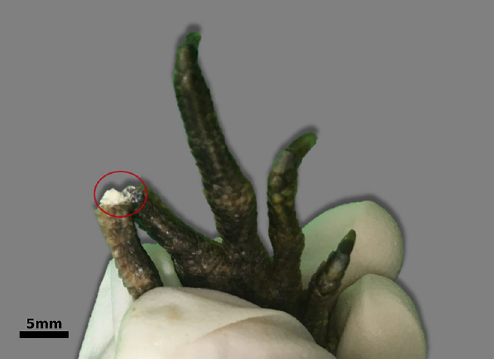
Figure 1. Hind limb of a water dragon with an opened metatarsophalangeal joint (red circle) containing chalky, white material.